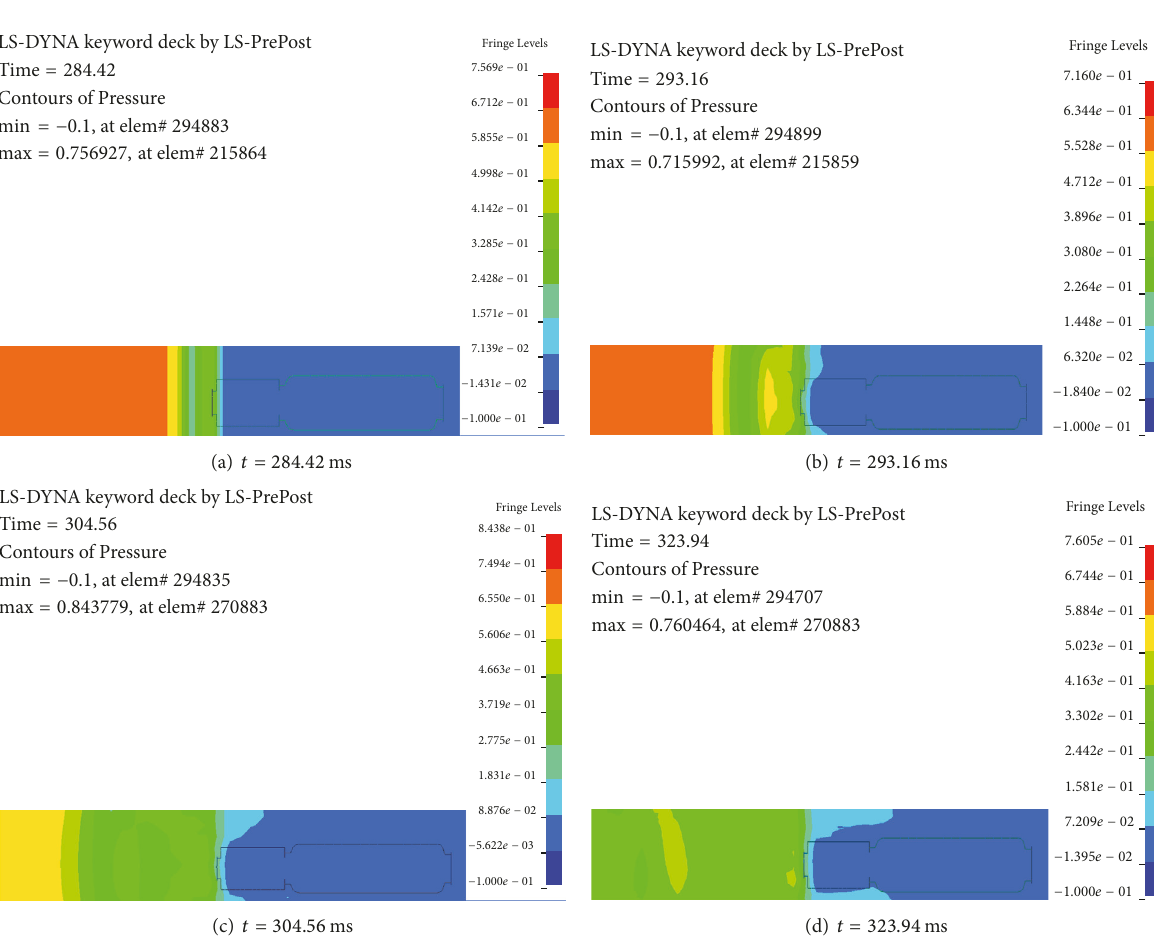
Figure 3: Mesh of rescue capsule and tunnel.